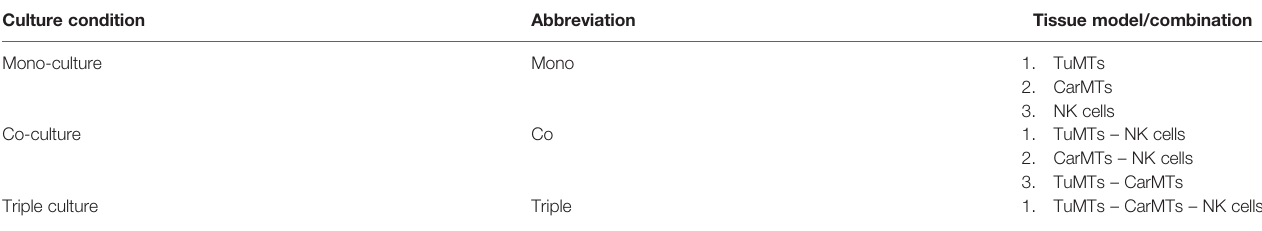
TABLE 1 | All cell culture conditions in the micro fl uidic on-chip cultures. Culture